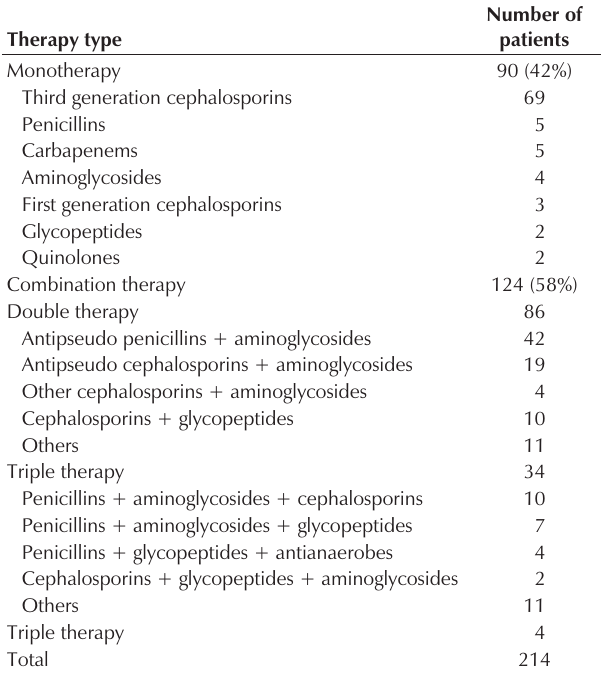
Selected initial courses of empirical